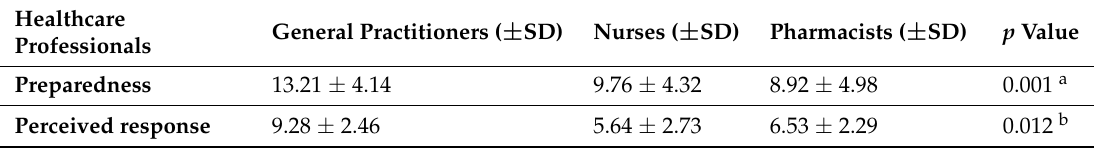
Table 6. Difference in preparedness score and perceived response score among healthcare